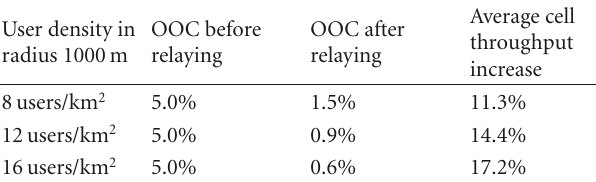
Table 1: OOC and throughput